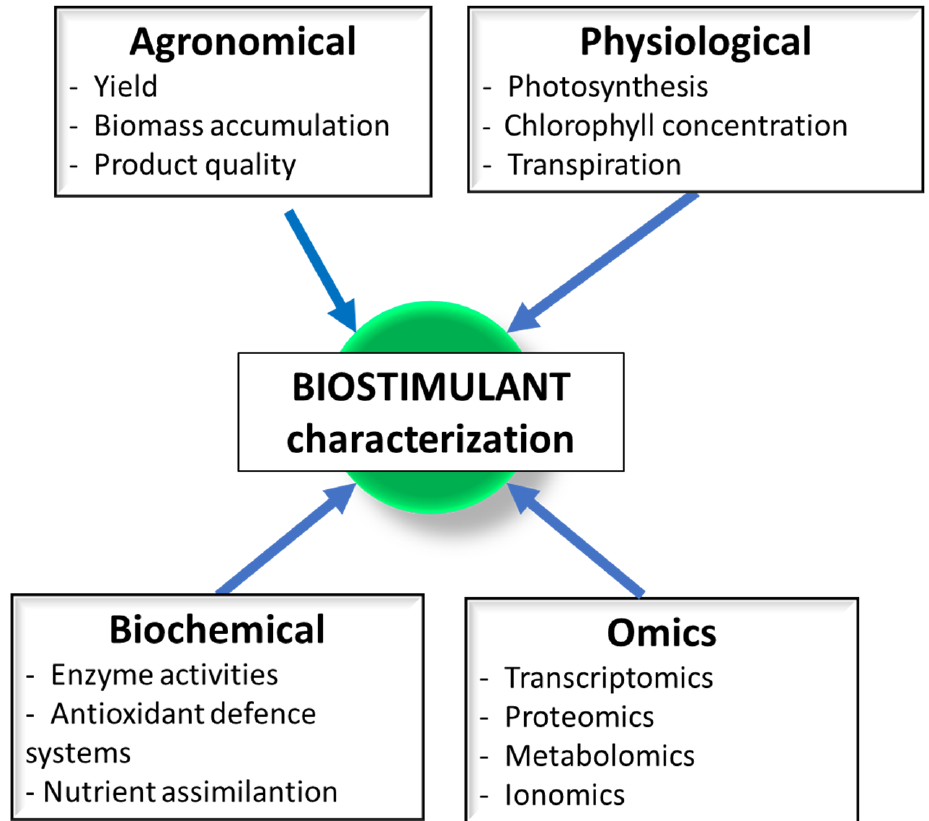
Figure 1. Multidisciplinary approach for the characterization of biostimulants based on crop response. Main parameters that should be considered and measured for each analyzed group.